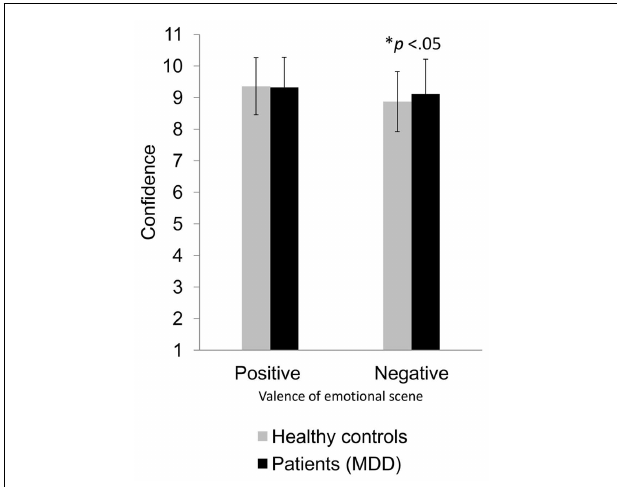
FIGURE 4 | Differences in rating confidence of patients with MDD and healthy controls for positive and negative emotional interactions . Average confidence ratings and their standard deviations are displayed as a function of participant group (healthy controls vs. patients with MDD) and valence of depicted emotional scene (positive vs. negative).The difference is significant at the 0.05